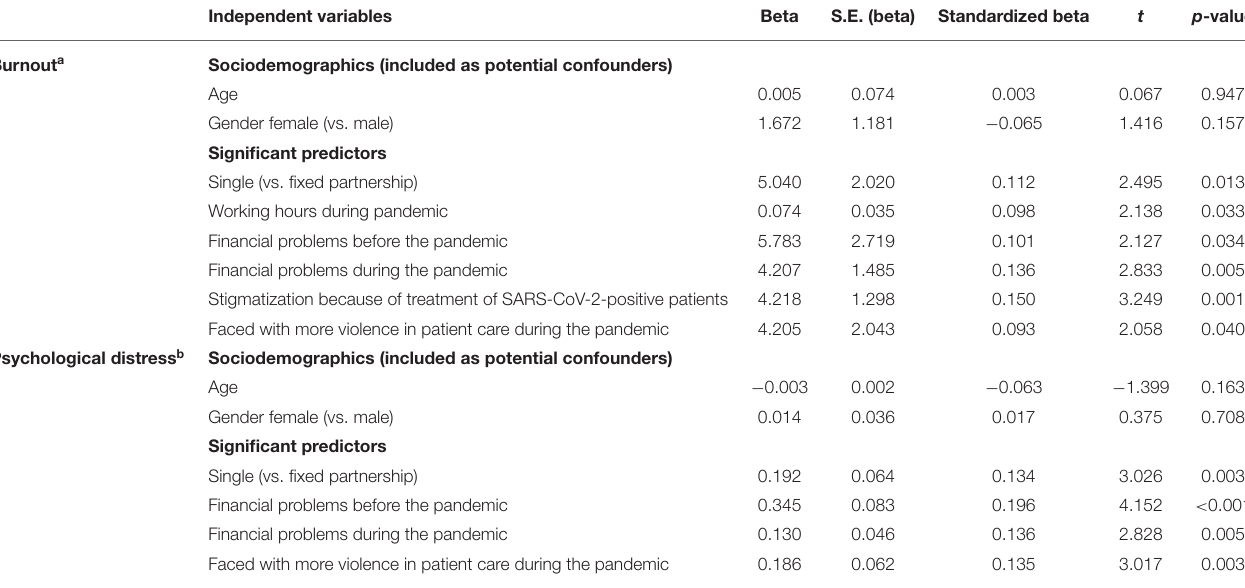
TABLE 5 | Linear Regression—Burnout (CBI total score) (A) and psychological distress (BSI-18 total score) (B) . Independent